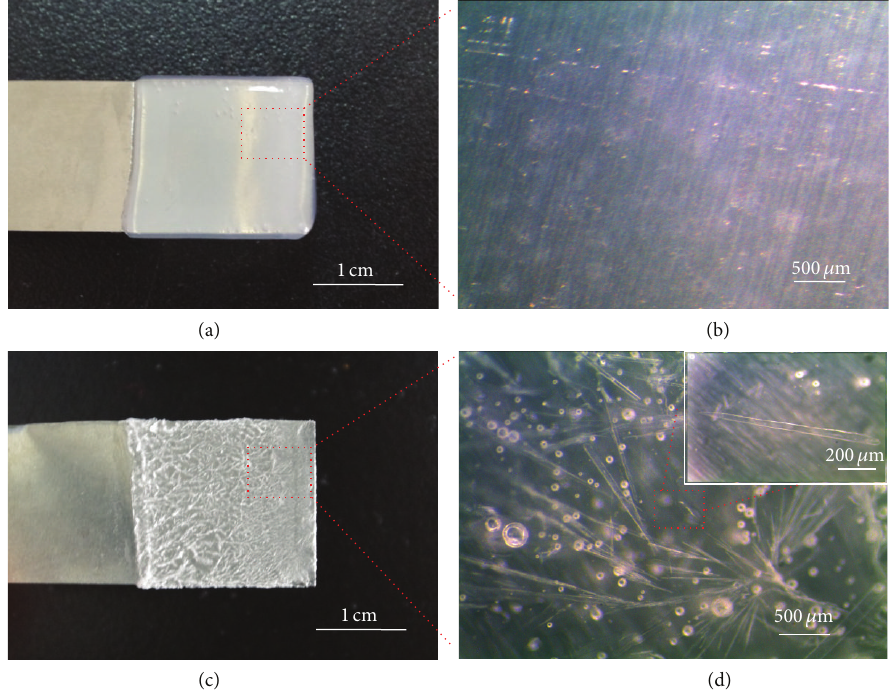
Figure 1: Photographs of the chitosan-ibuprofen composite hydrogel on titanium plate. Wet (a) and dried (c) chitosan-ibuprofen composite hydrogel and its corresponding magnified photographs (b) and (d). The insert of (d) shows the enlarged ibuprofen needle-like